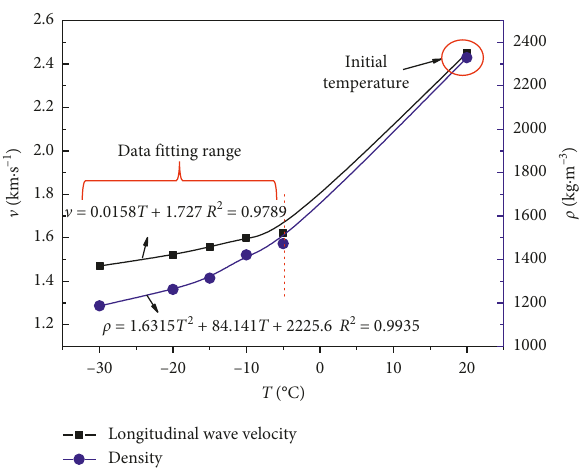
Figure 8: Relationship between physical parameters and F-T